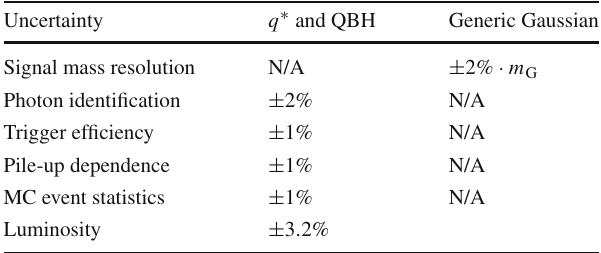
Table 1 Summary of systematic uncertainties in the signal event yield and shape included in the fit model. The signal mass resolution uncer- tainty affects the generic Gaussian signal shape, while the other uncer- tainties affect the event yield